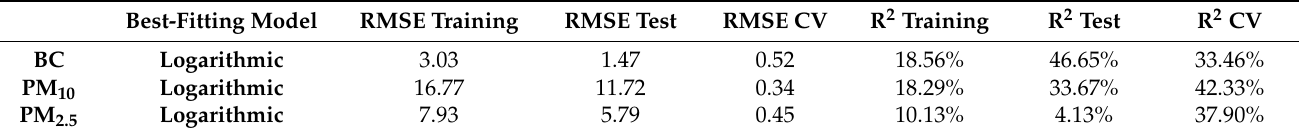
Table 3. Statistical characteristics of the best model prediction for PM 10 , PM 2.5 , and